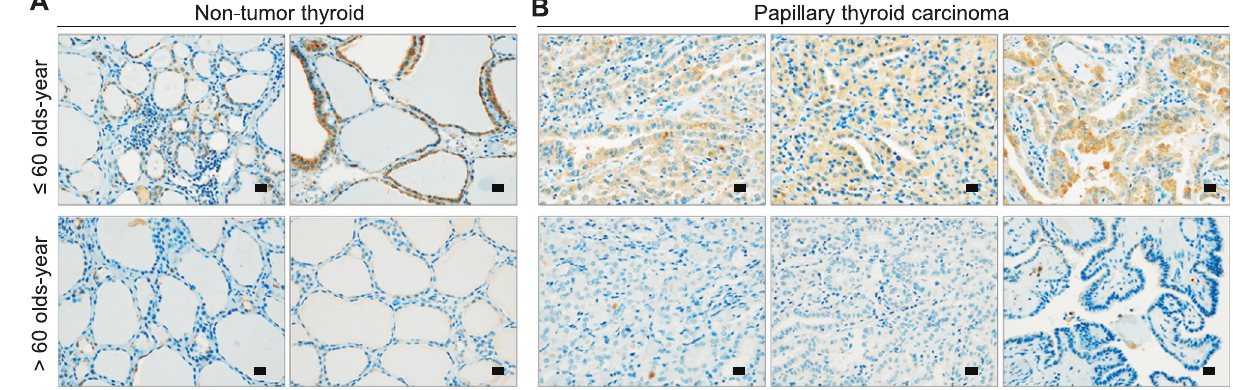
Fig. 6 Relationship between PER2 immunoexpression and aging in the human thyroid gland. A In non-tumor thyroid, PER2 immunostaining is more frequently observed in the thyroid follicular epithelium of individuals aged <60 years than in those aged >60 years. B PER2 is more frequently expressed in PTCs of individuals aged <60 years than in those aged >60 years. Scale bar, 20 μ